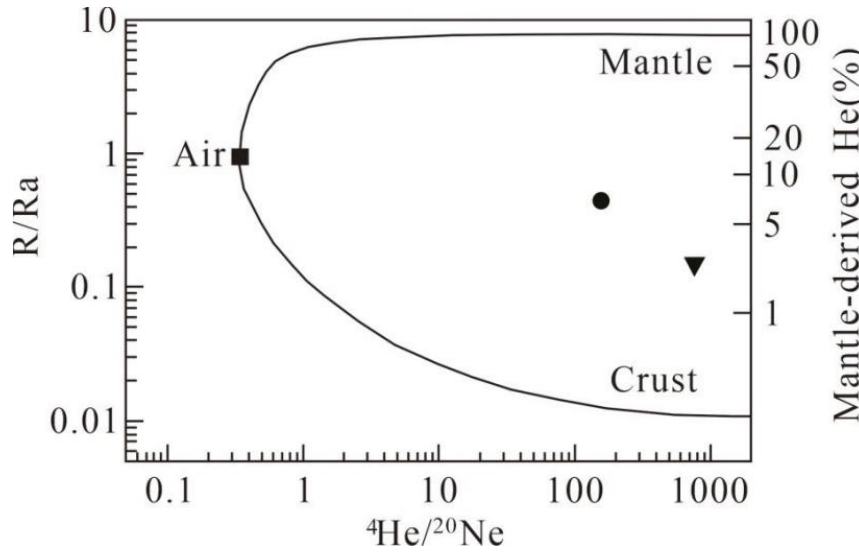
Figure 7. Plot of 3 He/ 4 He values vs. 4 He/ 20 Ne ratios of the hot spring